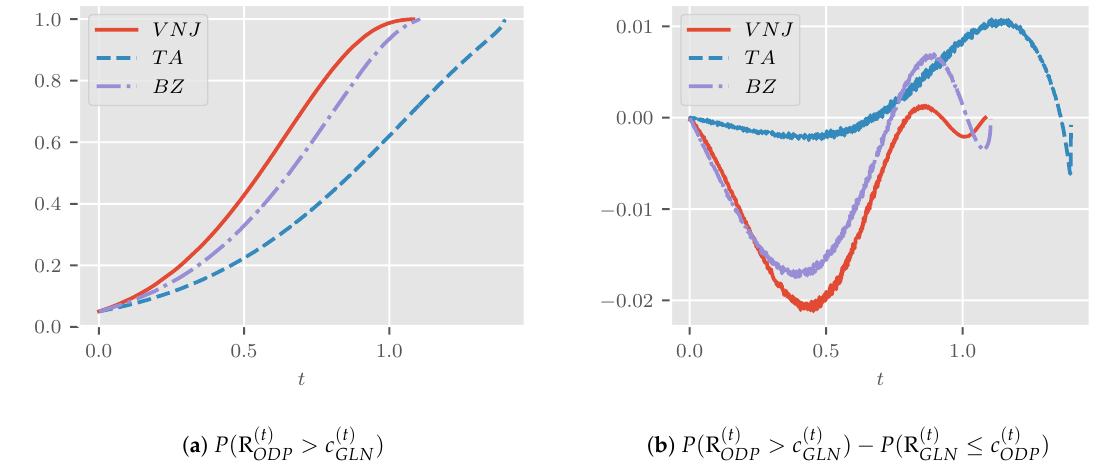
Figure 4. Power as t increases from zero to t max . Values for t max are 1.083 for VNJ , 1.396 for TA and 1.103 for BZ . ( a ) shows power when the null model is generalized log-normal, and ( b ) shows the difference in power between the two